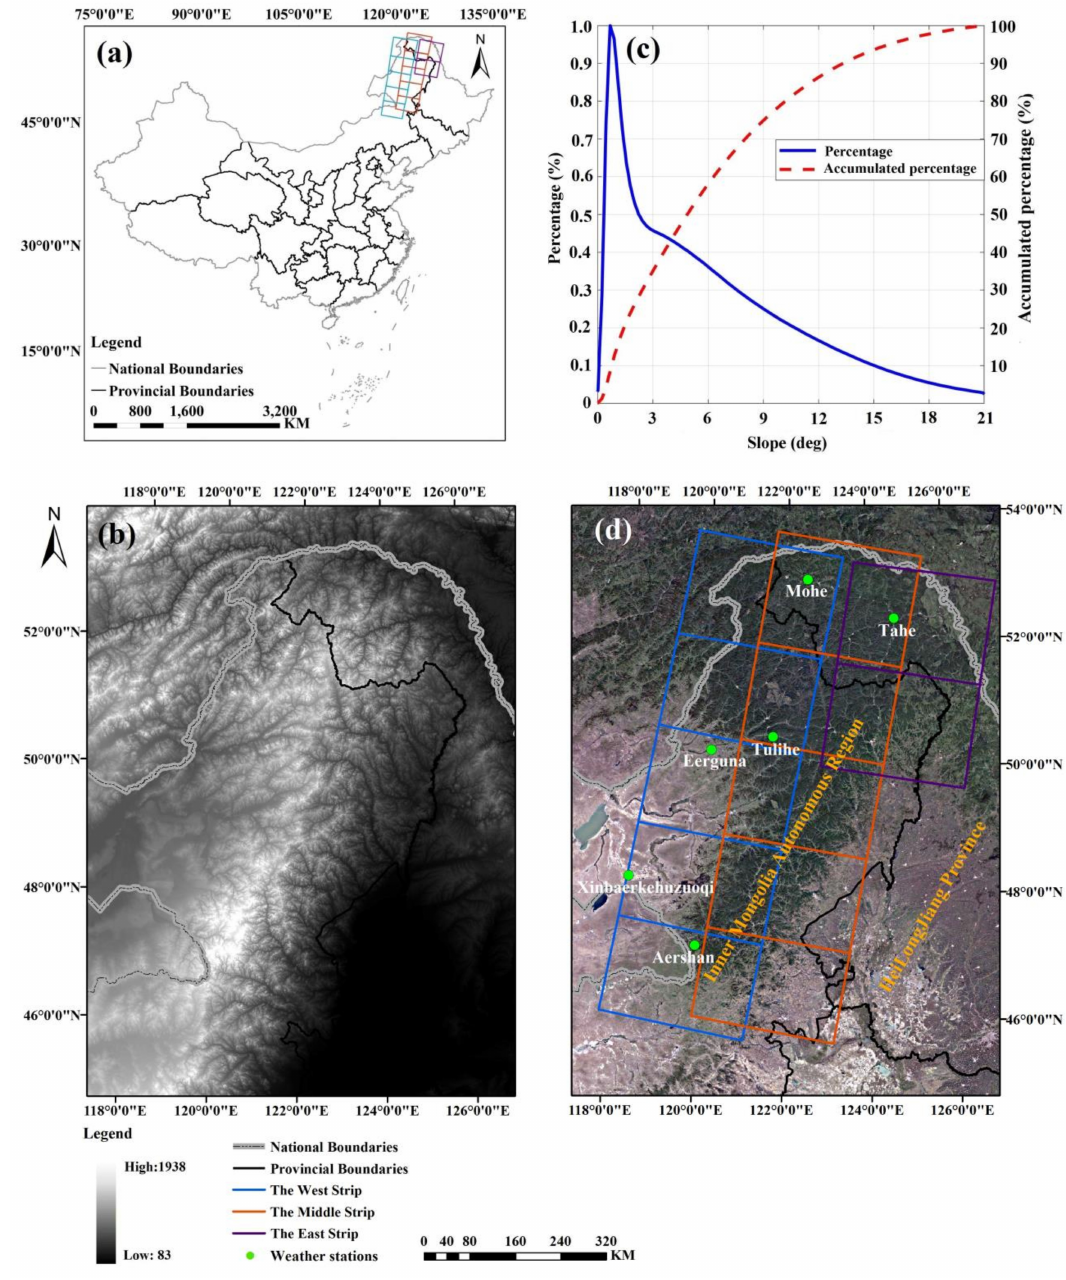
Figure 1. The location and terrain conditions of the study area: ( a ) Location of the Greater Khingan Mountains in China; ( b ) Digital elevation map (DEM) of study areas from Shuttle Radar Topography Mission (SRTM) data; ( c ) Histogram of the terrain slope; ( d ) Spatial coverage of Sentinel-1 data on a true color image from GoogleEarth TM and the distribution of 6 weather stations (represented by green dots) used in this study. The blue, orange, and purple polygons are locations of the west, middle, and east strips of Sentinel-1 images,